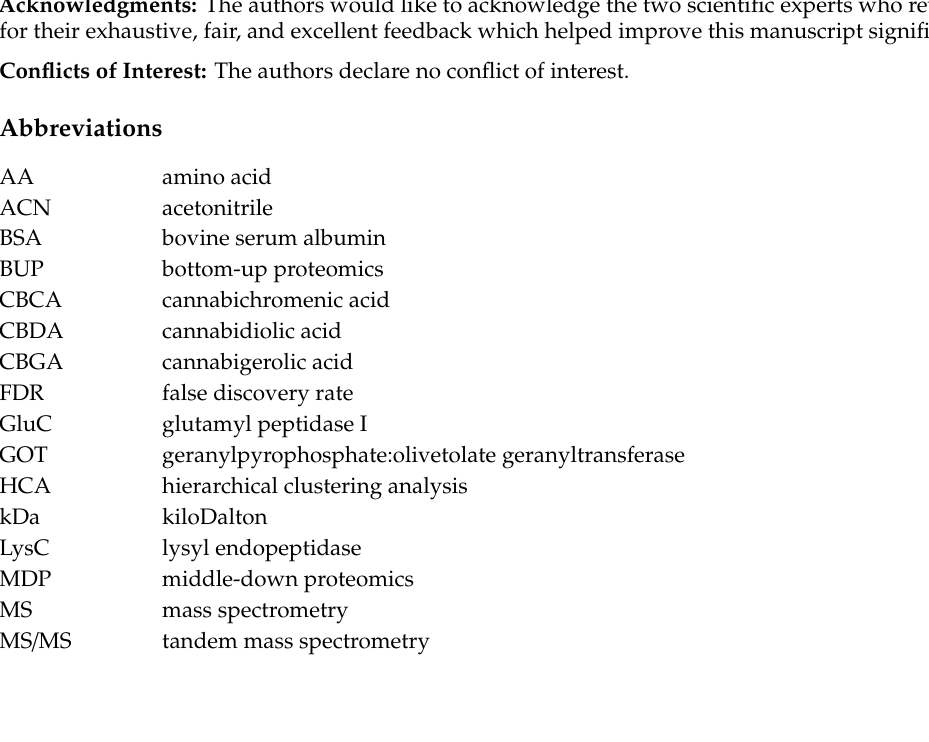
Supplementary Table S3: List of medicinal cannabis accessions identified by shotgun proteomics. Supplementary Table S4: List of medicinal cannabis unique proteins identified by shotgun